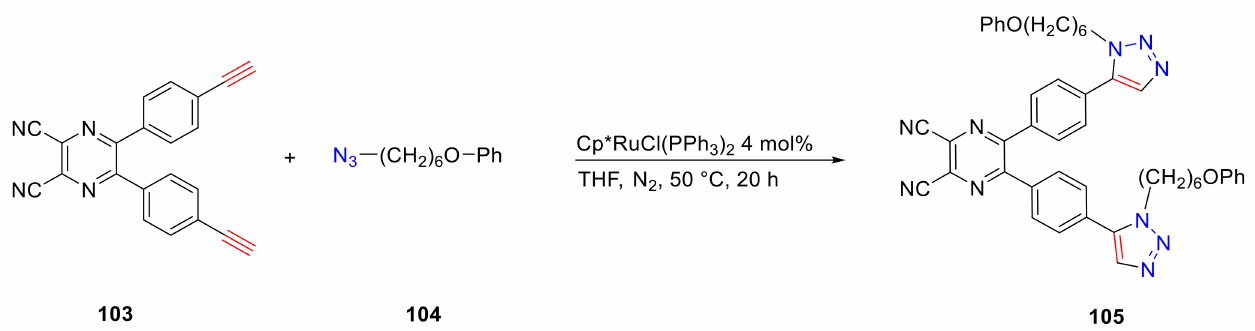
using Cp*RuCl(PPh 3 ) 2 as catalyst (Scheme 33). Successively, Anand et al. [88] published a click chemistry-based approach for the regioselective synthesis of 1,5-coumarinyl 1,2,3- triazoles 108 (Scheme